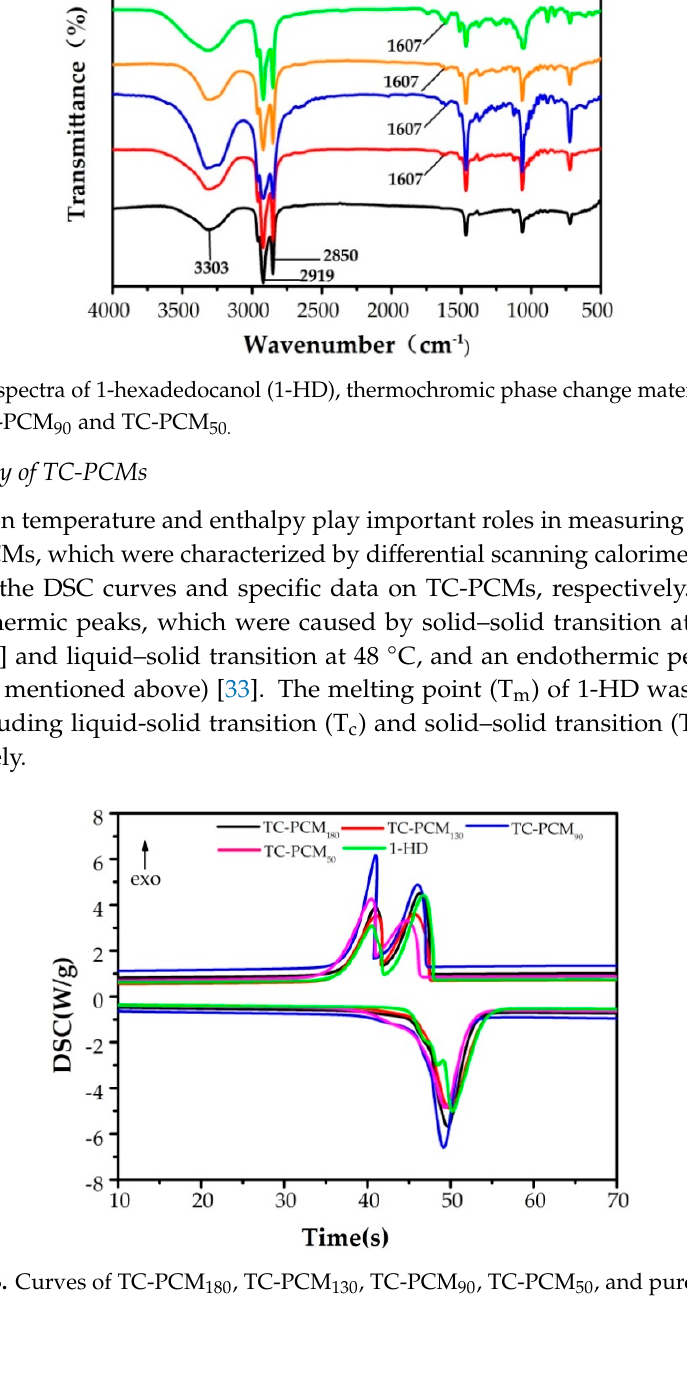
Figure 3. Curves of TC-PCM 180 , TC-PCM 130 , TC-PCM 90 , TC-PCM 50 , and pure 1-HD.